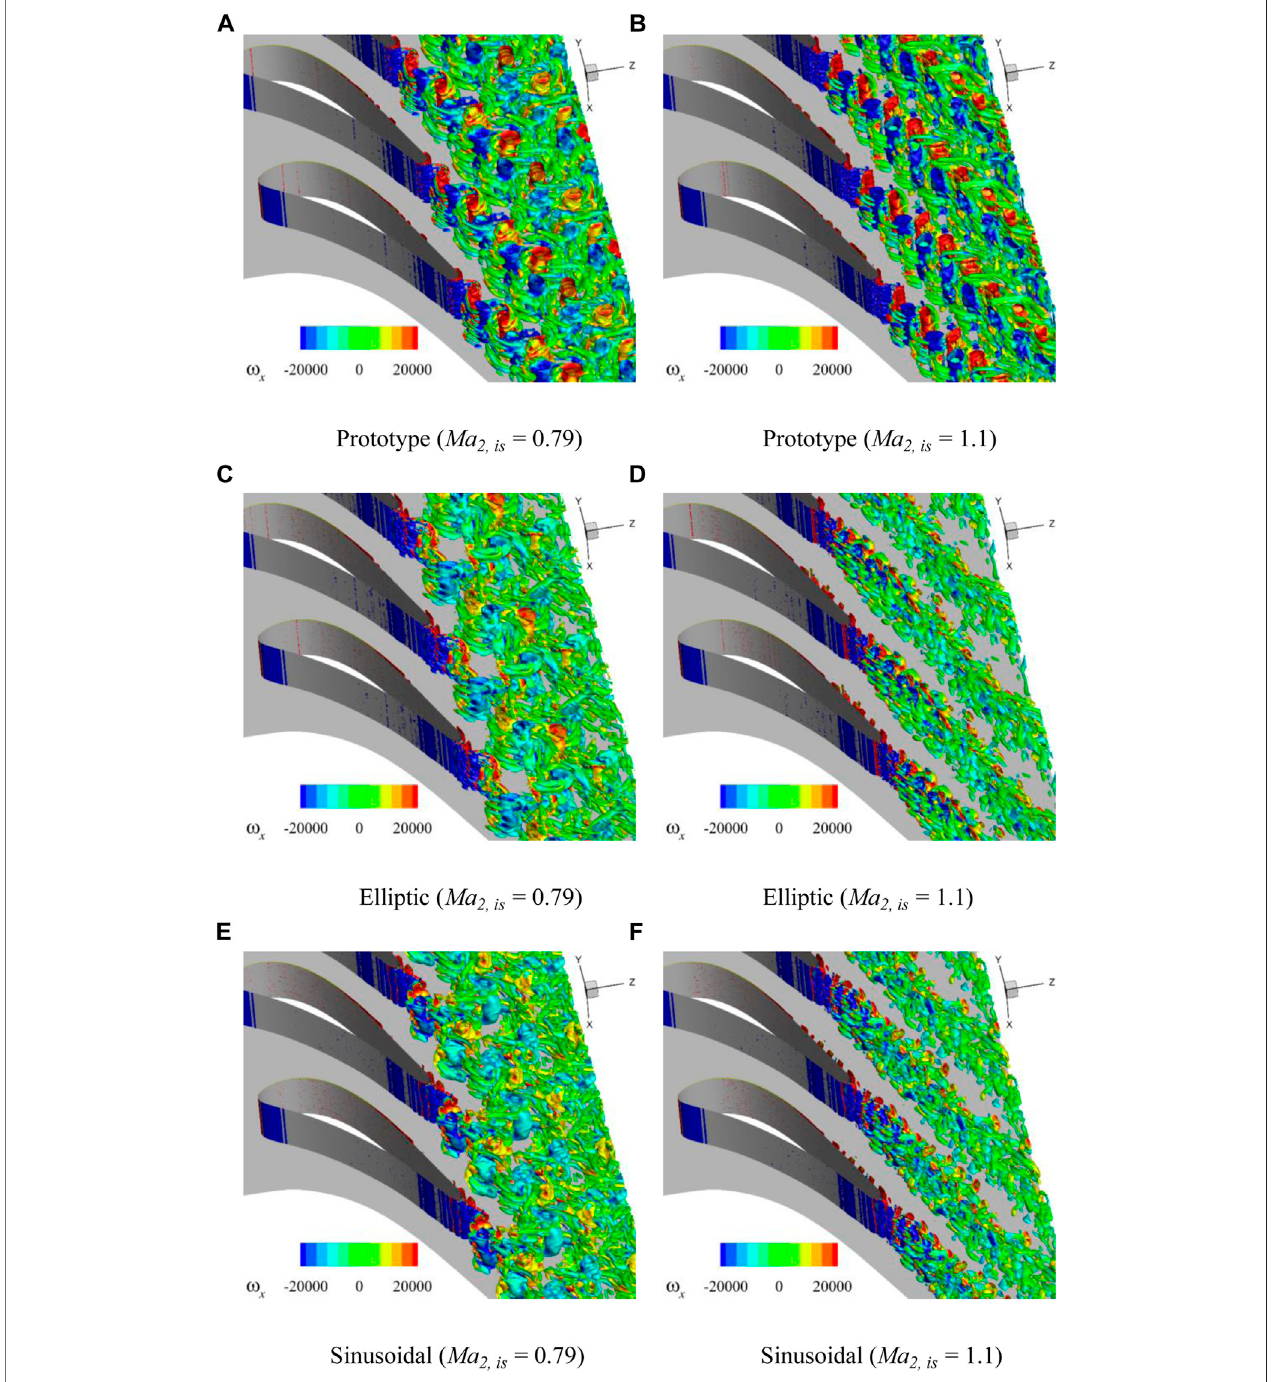
FIGURE 9 | Isosurfaces of Q criterion ( Q (cid:1) 1 × 10 7 ) for the four pro fi les under Ma 2 , is (cid:1) 0 . 79 and Ma 2 , is (cid:1) 1 . 1. (A) Prototype ( Ma 2 , is (cid:1) 0 . 79 ) (B) Prototype ( Ma (cid:1) 1 . 1 ) . (C) Elliptic ( Ma (cid:1) 0 . 79 ) (D) Elliptic ( Ma 2 , is 2 , is (H) Biomimetic ( Ma 2 , is (cid:1) 1 . 1 ) .